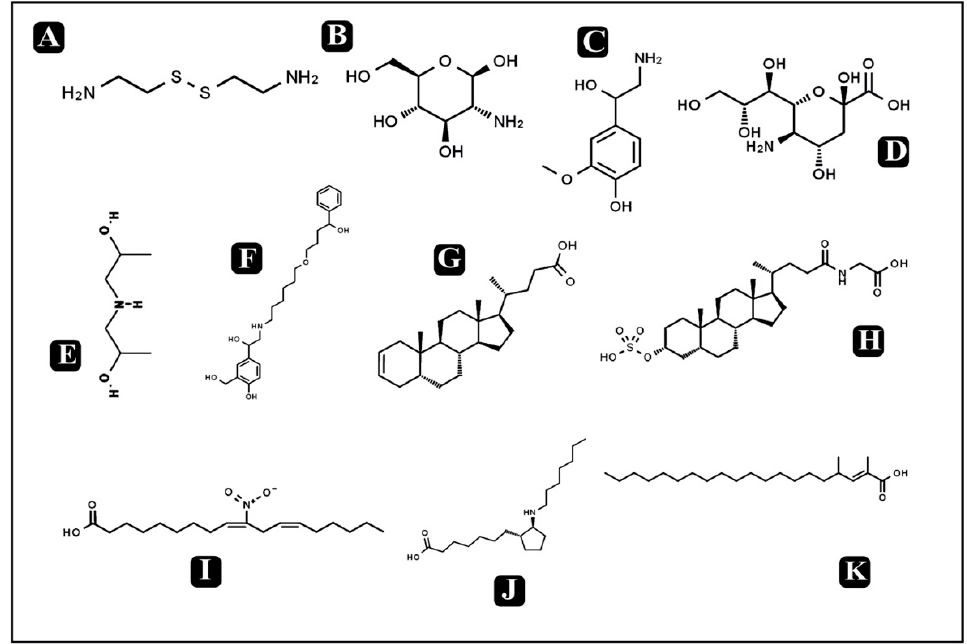
Figure 10. Chemical structures of identified compounds by HR-LCMS. ( A ) Cysteamine ( B ) glucosamine, ( C ) normetanephrine, ( D ) neuraminic acid, ( E ) bis (2-hydroxypropyl) amine, ( F ) hydroxysalmeterol, ( G ) 5-beta-chol-2-en-24-oic acid, ( H ) sulfolithocholylglycine, ( I ) 10-nitro,9Z,12Z-octadecadienoic acid, ( J ) 13-Azaprostanoic acid, ( K ) 2,4-dimethyl-2-eicosenoic